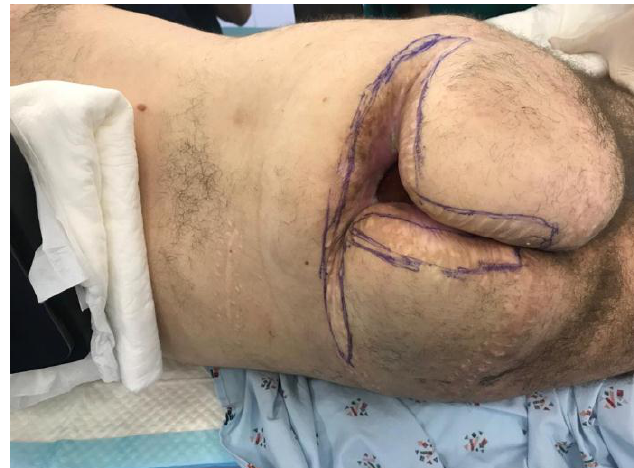
Figure 1: Stage 4 pressure